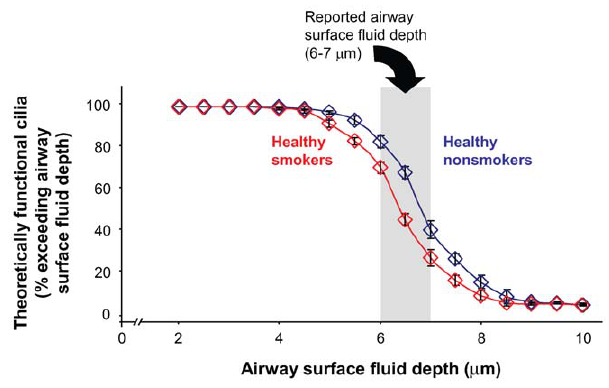
Figure 5. Theoretical effect of smoking on ciliary contribution to mucociliary clearance. The models of cilia/mucus interaction propose that the tip of the cilia must pass through the periciliary fluid to contact the mucus in order to generate mucus movement [15,17,39,40]. Using the data generated in the study of hydrated, unfixed airway epithelial cells, the graph shows the proportion of cilia that would extend through the airway surface fluid (y-axis, ‘‘effective cilia’’) at a variety of hypothetical airway surface fluid depths (x-axis).The range of reported normal depths of airway surface fluid is shown in gray. Proportions of effective cilia are shown for nonsmokers (blue) and smokers (red).